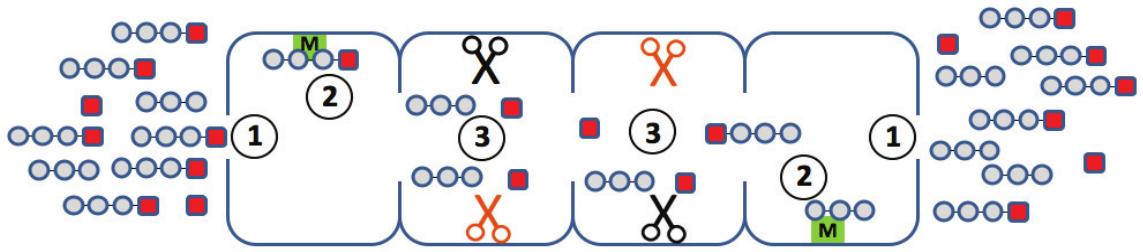
Figure 2. Elementary steps along the reaction path, which may determine the degradation kinetics of a small fluorogenic peptide. ( 1 ) Uptake and release of the peptide through the openings (gating); ( 2 ) binding of the peptide to non-catalytic modifier sites; ( 3 ) generation of the chromophore with a different efficiency at different active